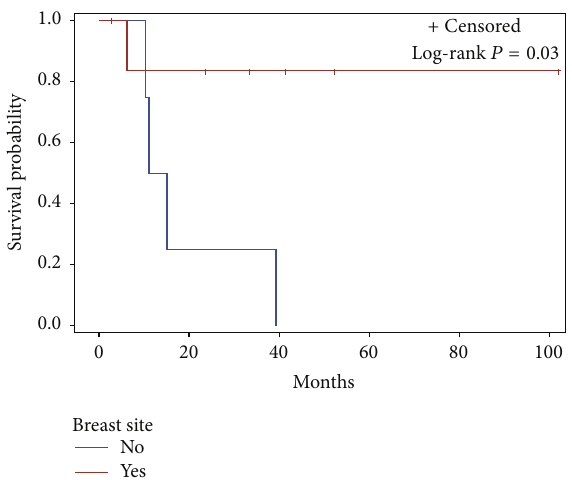
Figure 7: Overall survival in RAA patients with breast site versus nonbreast